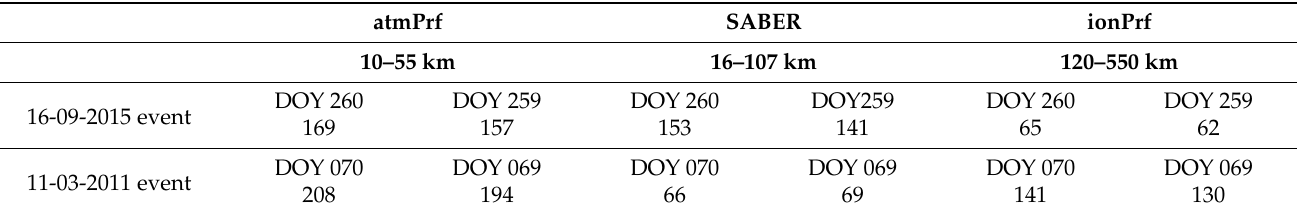
Table 1. The cover height and the numbers of profiles for the three datasets in this study.